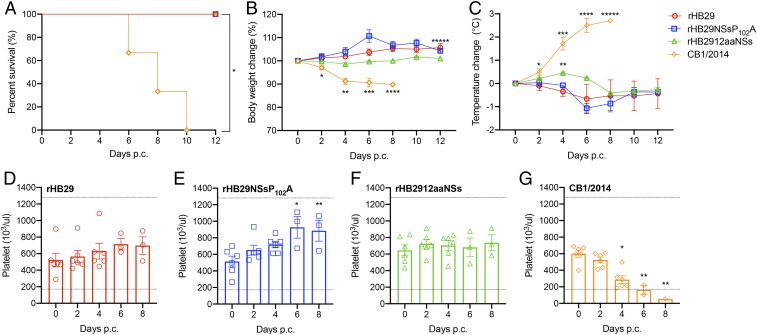
Survival, relative body weight, temperature change and hematological analysis of immunized ferrets in a lethal challenge model. Six ferrets in each group were i.m. inoculated with 107.6 TCID50 of CB1/2014. Survival (A) relative body weight (B) and temperature (C) were assessed and are shown as SEM. Data (means ± SEM) are presented in B and C. Blood from infected ferrets was collected every other day and hematological examination was performed using a Celltac hematology analyzer. Platelet counts from ferrets preimmunized with rHB29 (D), rHB29NSsP102A (E), or rHB2912aaNSs (F) and subsequently challenged with CB1/2014 or animals infected with CB1/2014 only (G) are shown. CB1/2014 infected ferrets were additionally infected for positive control. Normal range of platelet counts in ferrets are 171.7 to 1,280.6 × 103/µL (46, 58). The dashed lines indicate the normal value range for platelet counts. The asterisks indicate significance compared to each day p.i. sample. The 2-tailed Mantel–Cox method (A) or the one-way ANOVA with Dunnett multiple comparison test (B–F) was used to assess P values by the 2-tailed, unpaired t test. *P = 0.0025 (A); *P < 0.02, **P < 0.0001, ***P = 0.0053, ****P = 0.0019, and *****P = 0.0478 (B); *P = 0.0377, **P = 0.0140, ***P < 0.0001, ****P = 0.0025, and *****P = 0.0243 (C); *P = 0.0055 and **P = 0.0124 (E); and *P = 0.0003 and **P = 0.0005 (G).